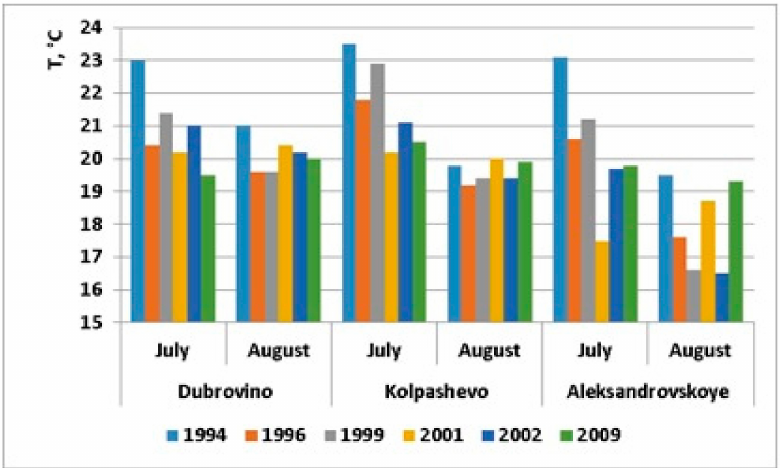
Figure 3. Average monthly water temperature.